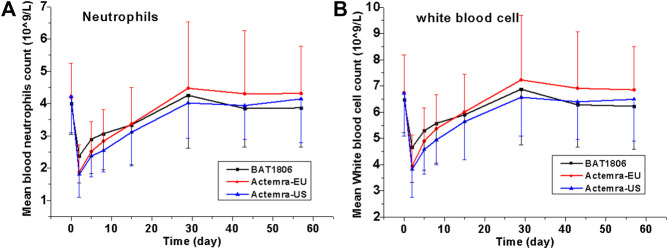
Absolute values for neutrophil and white blood cell counts over time. Data are presented as the means ± standard deviation for the BAT1806, RoActemra-EU, and Actemra-US groups.